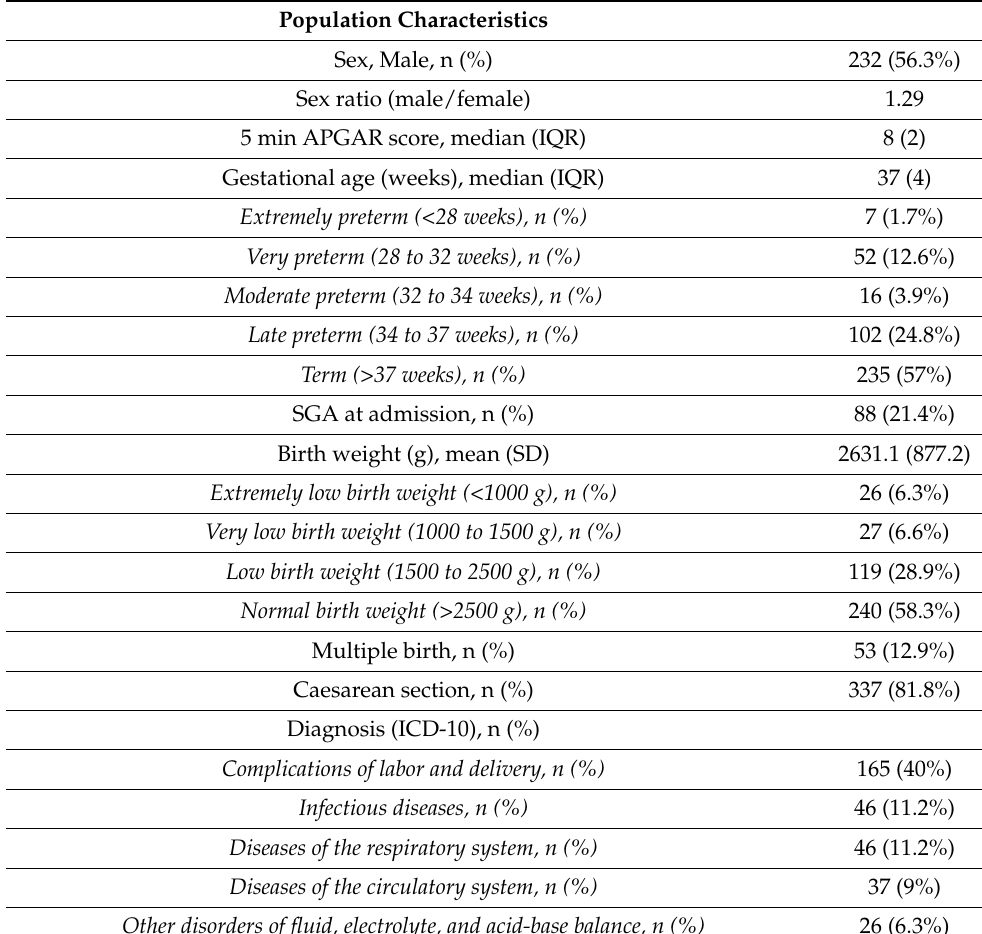
Table 1. Data acquisition parameters of the study (N =